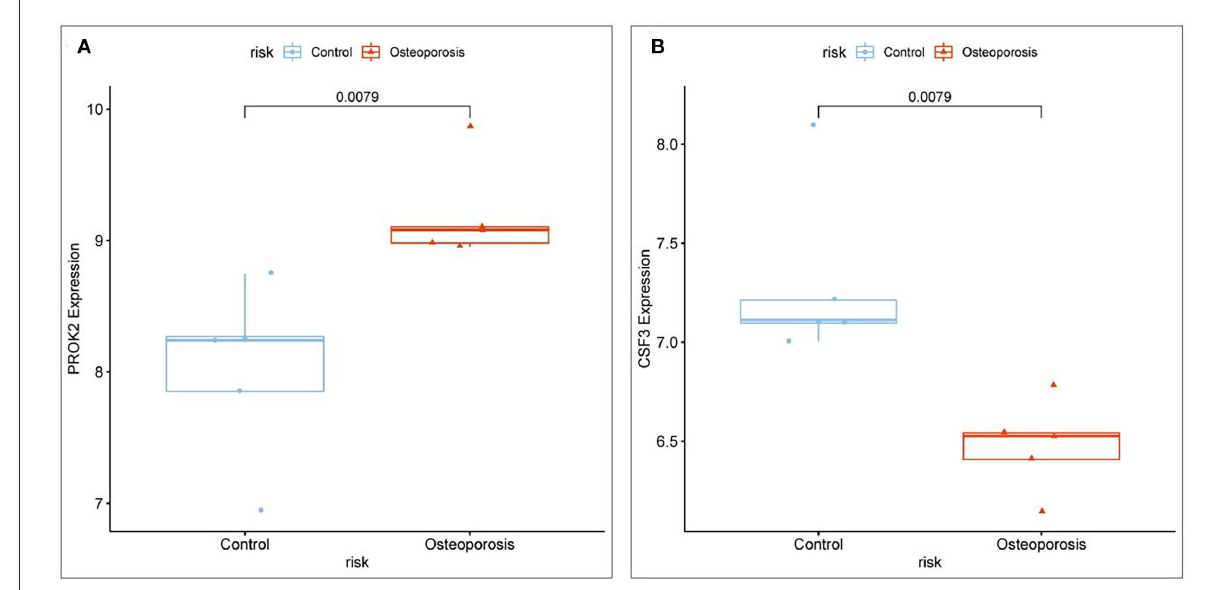
FIGURE7 Relative expression levels of core targets involved in OP inflammation. (A) PROK2 relative expression; (B) CSF3 relative expression.